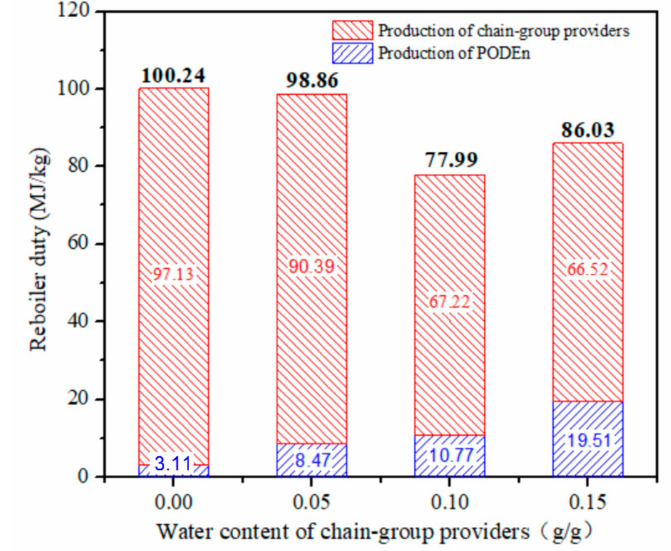
Figure 12. Reboiler duty per unit mass of product with di ff erent water content. (Methylal / CH 2 O mass ratio